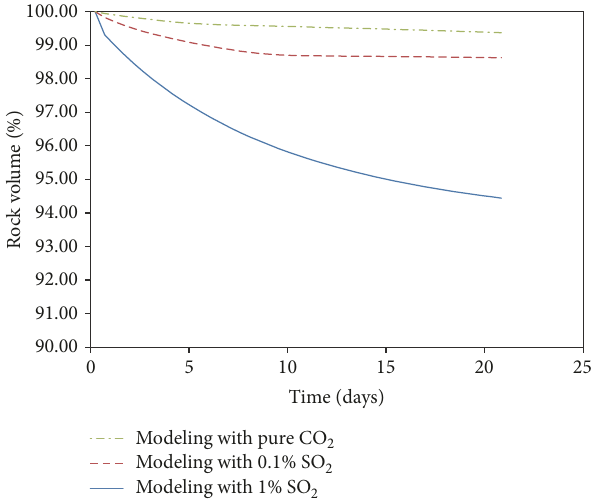
Figure 7: Changes in the volume of total minerals in the modeling (green dashed line = pure CO 2 case, red dashed line = 0.1% SO 2 case, and blue solid line = 1% SO 2